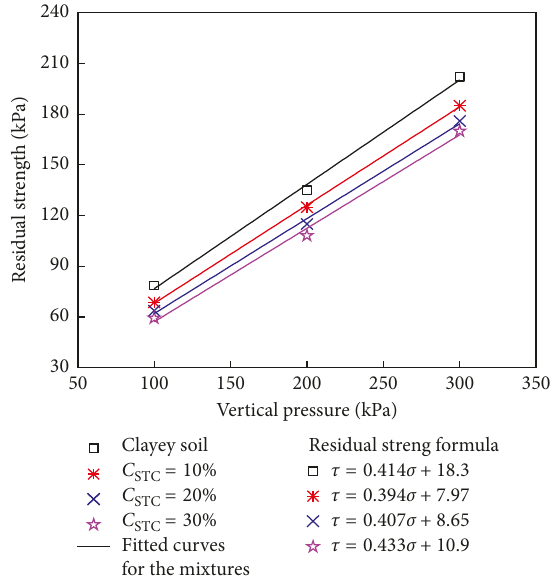
Figure 13: Envelopes of the residual shear strength for mixtures.